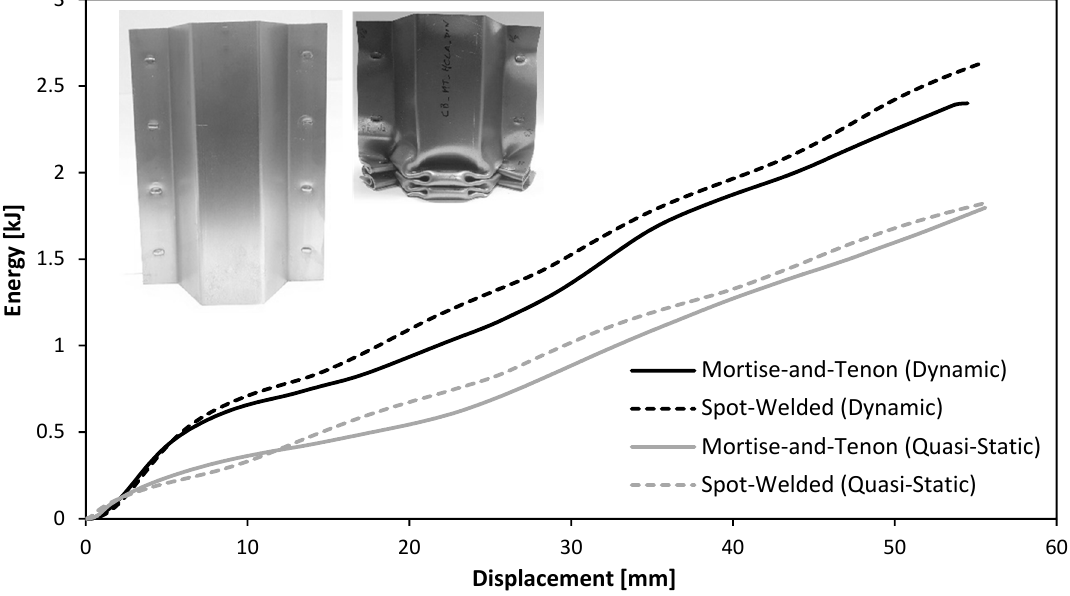
Figure 10. Experimental evolution of the absorbed energy with displacement for the axial crush tests of thin-walled crash boxes with double-hat section assembled by sheet-bulk compression with “mortise-and-tenon” joints and by resistance spot-welding: ( a ) quasi-static tests; ( b ) dynamic tests.